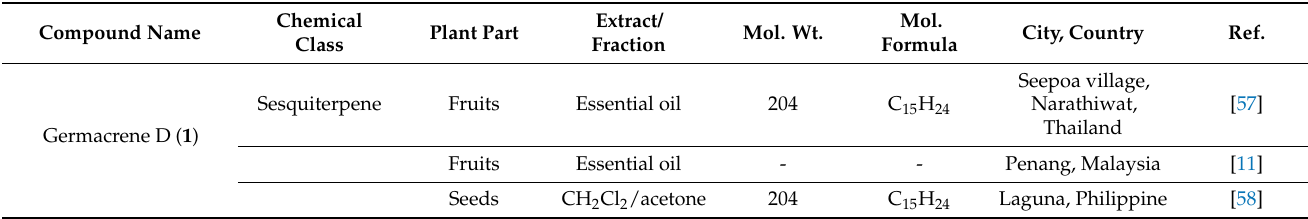
Table 4. List of the reported phytoconstituents from Lansium domesticum